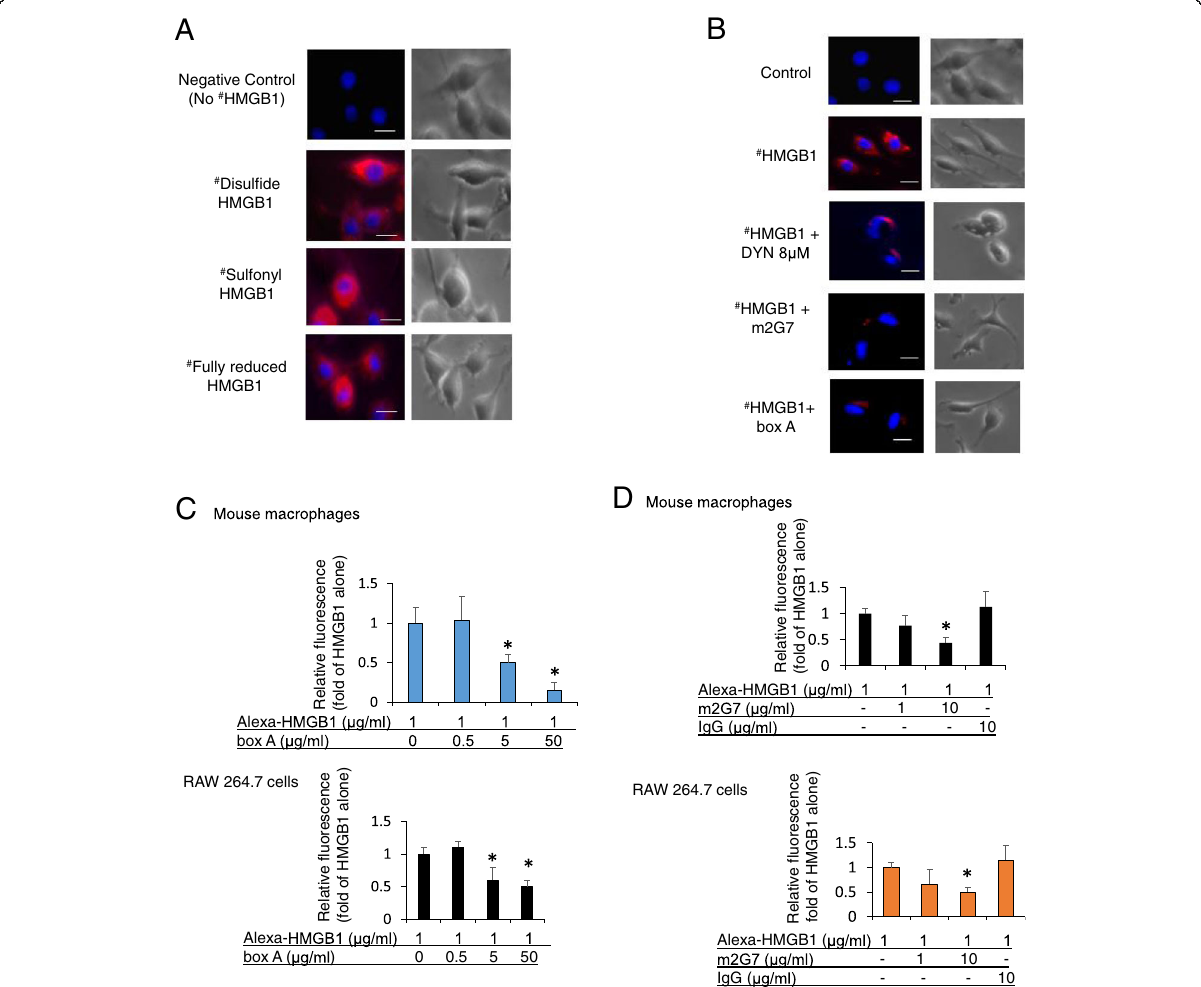
Fig. 3 Anti-HMGB1 m2G7 and box A inhibited macrophages endocytosis of HMGB1. a . Murine macrophage-like RAW 264.7 cells seeded on 24- well culture plate on cover slips (1 × 10 4 /well) were incubated with Alexa 555 labeled (red) isoforms of HMGB1 (disulfide, sulfonyl and fully reduced) for 2 h at 37 °C. Endocytic uptake of HMGB1 was visualized via fluorescence microscope. Nuclei were counterstained with DAPI (blue). Right panel shows corresponding phase contrast image of cells. Data are representative from 4 independent experiments. Scale bar = 10 μ m. b . RAW 264.7 cells seeded on 24-well culture plate on cover slips (1 × 10 4 /well) were incubated with Alexa 555 labeled HMGB1 ( # red) alone or plus Dynasore (DYN, 8 μ M), m2G7 (5 μ g/ml), or box A (50 μ g/ml) for 2 h at 37 °C. Endocytic uptake of HMGB1 was visualized. Right panel shows corresponding phase contrast image of cells. Data are representative from 3 to 4 independent experiments. Scale bar = 10 μ m. c . Thioglycollate- elicited mouse primary macrophages (upper) or RAW 264.7 cells (lower) were seeded on 24-well culture plate on cover slips (1 × 10 4 /well) and incubated with Alexa 555-HMGB1, alone or with box A for 2 h at 37 °C. HMGB1 endocytosis results expressed as fold of Alexa 555-HMGB1 alone. N = 30 – 42 cells per treatment. *: P < 0.05 vs. HMGB1 alone. d . Thioglycollate-elicited mouse primary macrophages (upper) or RAW 264.7 cells (lower) were seeded on 24-well culture plate on cover slips (1 × 10 4 /well) and incubated with Alexa 555 labeled HMGB1 (1 μ g/ml) alone or with m2G7 or mouse IgG for 2 h at 37 °C. Endocytosis results expressed as fold of Alexa 555-HMGB1 alone. N = 32 – 44 cells per treatment. *: P < 0.05